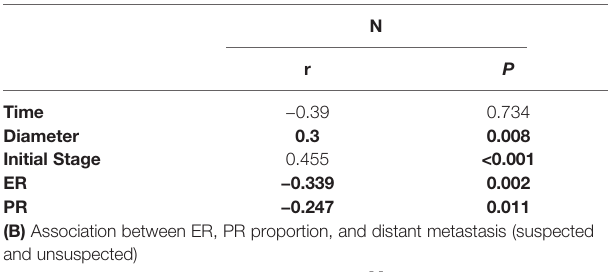
TABLE 2 | Association between ER, PR proportion, and extraaxillary lymph node metastasis or distant metastasis by simple correlation. (A) Association between ER, PR proportion, and extraaxillary lymph node metastasis (suspected and